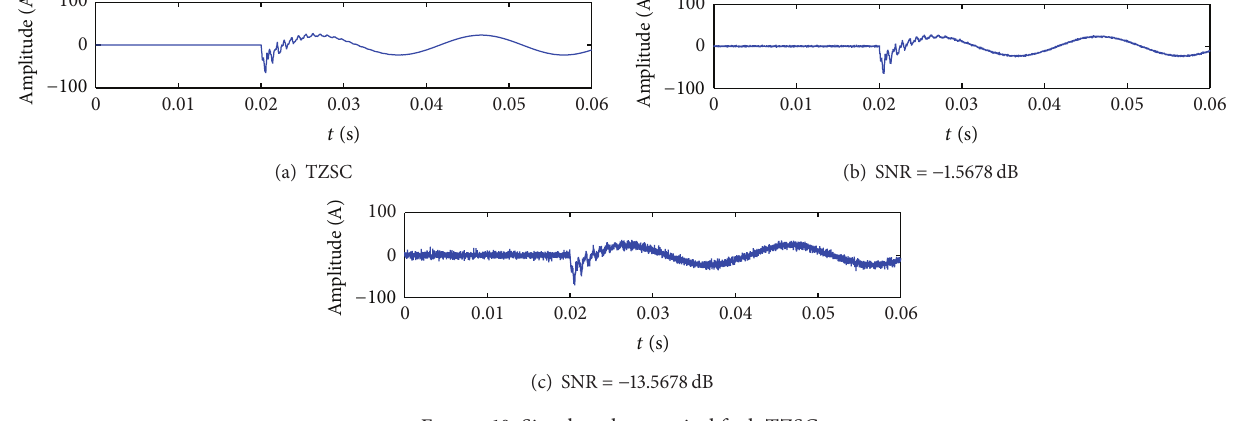
Figure 10: Simulate the practical fault TZSC.